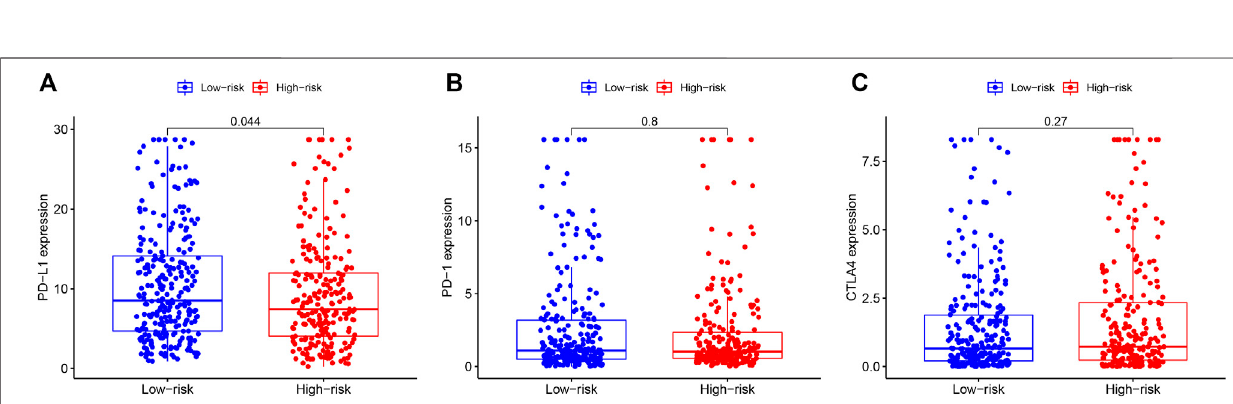
FIGURE 9 | TICs pro fi le of THCA cases (A) Violin plot for quanti fi cation of 22 TIC subtypes between low- and high- RS groups. (B) Memory B cells in fl uencing survival outcome of THCA patients. TIC, tumor-in fi ltrating immune cell; THCA, thyroid carcinoma; RS, risk score.